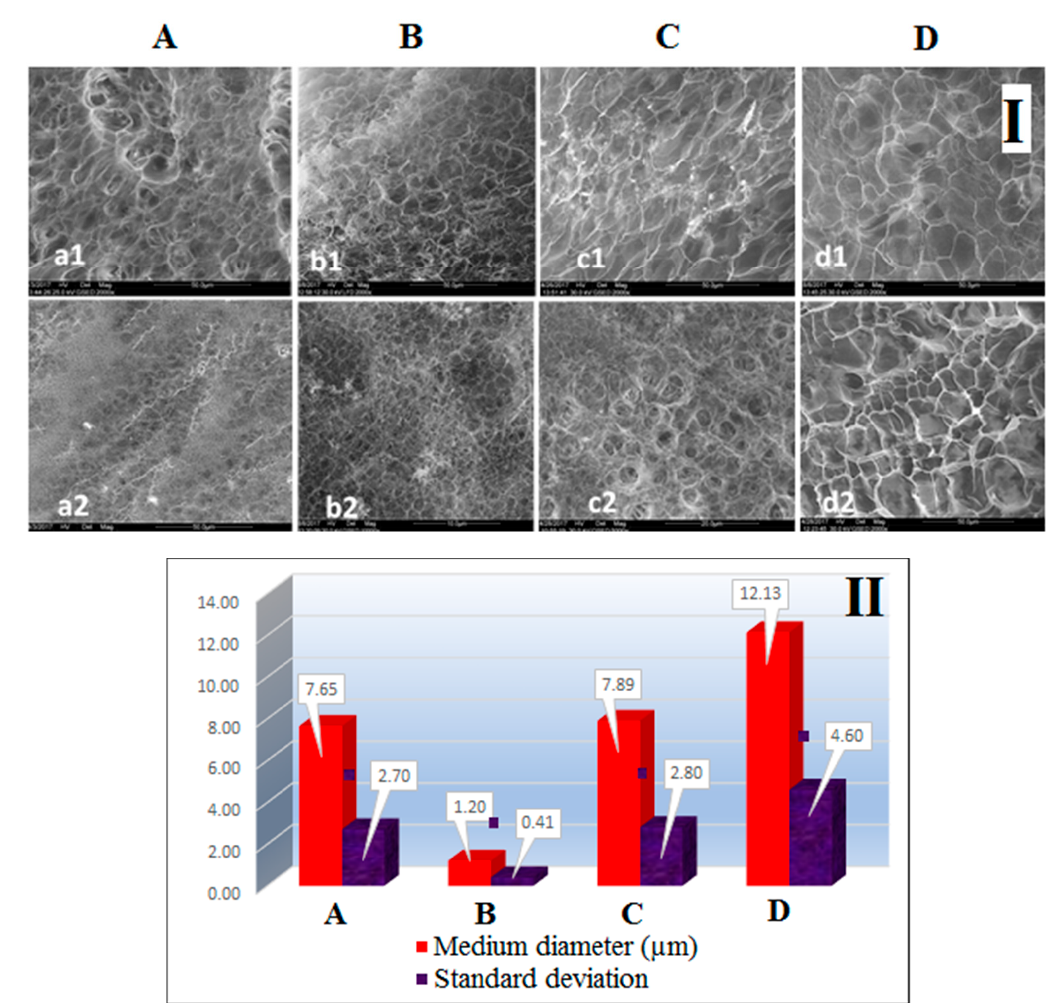
Figure 7. ( I ) SEM Images showing the microstructure aspect on fracture and surface of pure PMAA ( A ) and PMAA-Cl 93A ( B ), PMAA-Cl 93A-C8 ( C ), PMAA-Cl 93A-C18 ( D ) nanocomposites; a1-sample A-fracture ( × 2000); a2-sample A-surface ( × 2000); b1-sample B-fracture ( × 2000); b2-sample B-surface ( × 10,000); c1-sample C-surface ( × 2000); c2-sample C-surface ( × 5000); d1-sample D-fracture ( × 2000); d2-sample D-surface ( × 2000); ( II ) The fineness of the structure, expressed by the mean pore diameter and uniformity, estimated by the standard deviation from the mean.